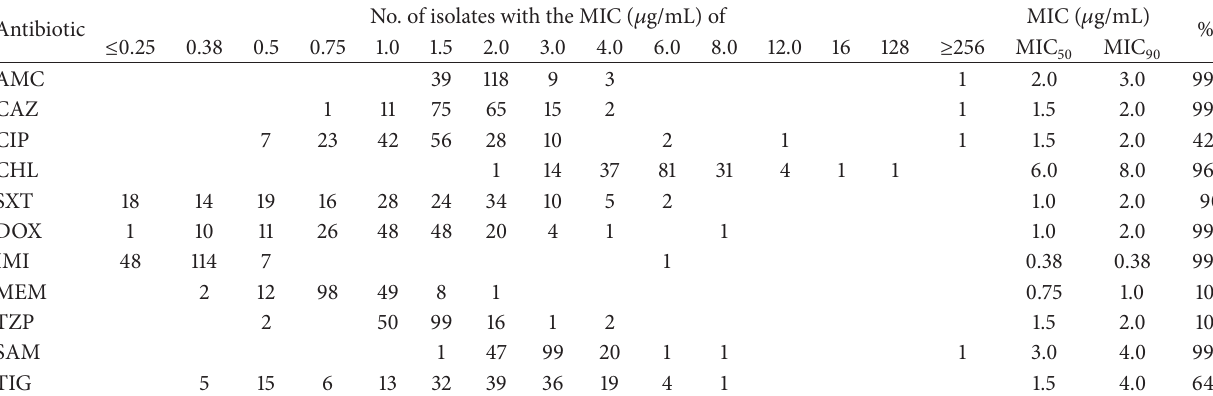
Table 2: The MIC of antibiotics against 170 Burkholderia pseudomallei